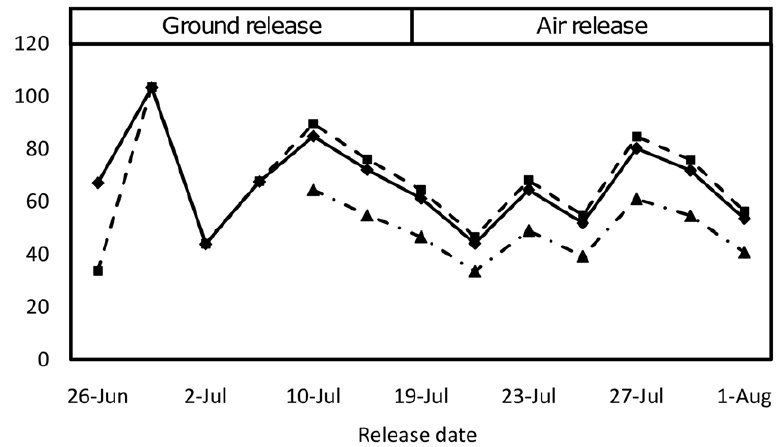
Figure 4. Number of moths of both strains released in Fields 1, 2 and 3 during the trial period. Field 1=diamond data points with solid line; Field 2=square data points with dotted line; and Field 3=triangular data points with dotted line.